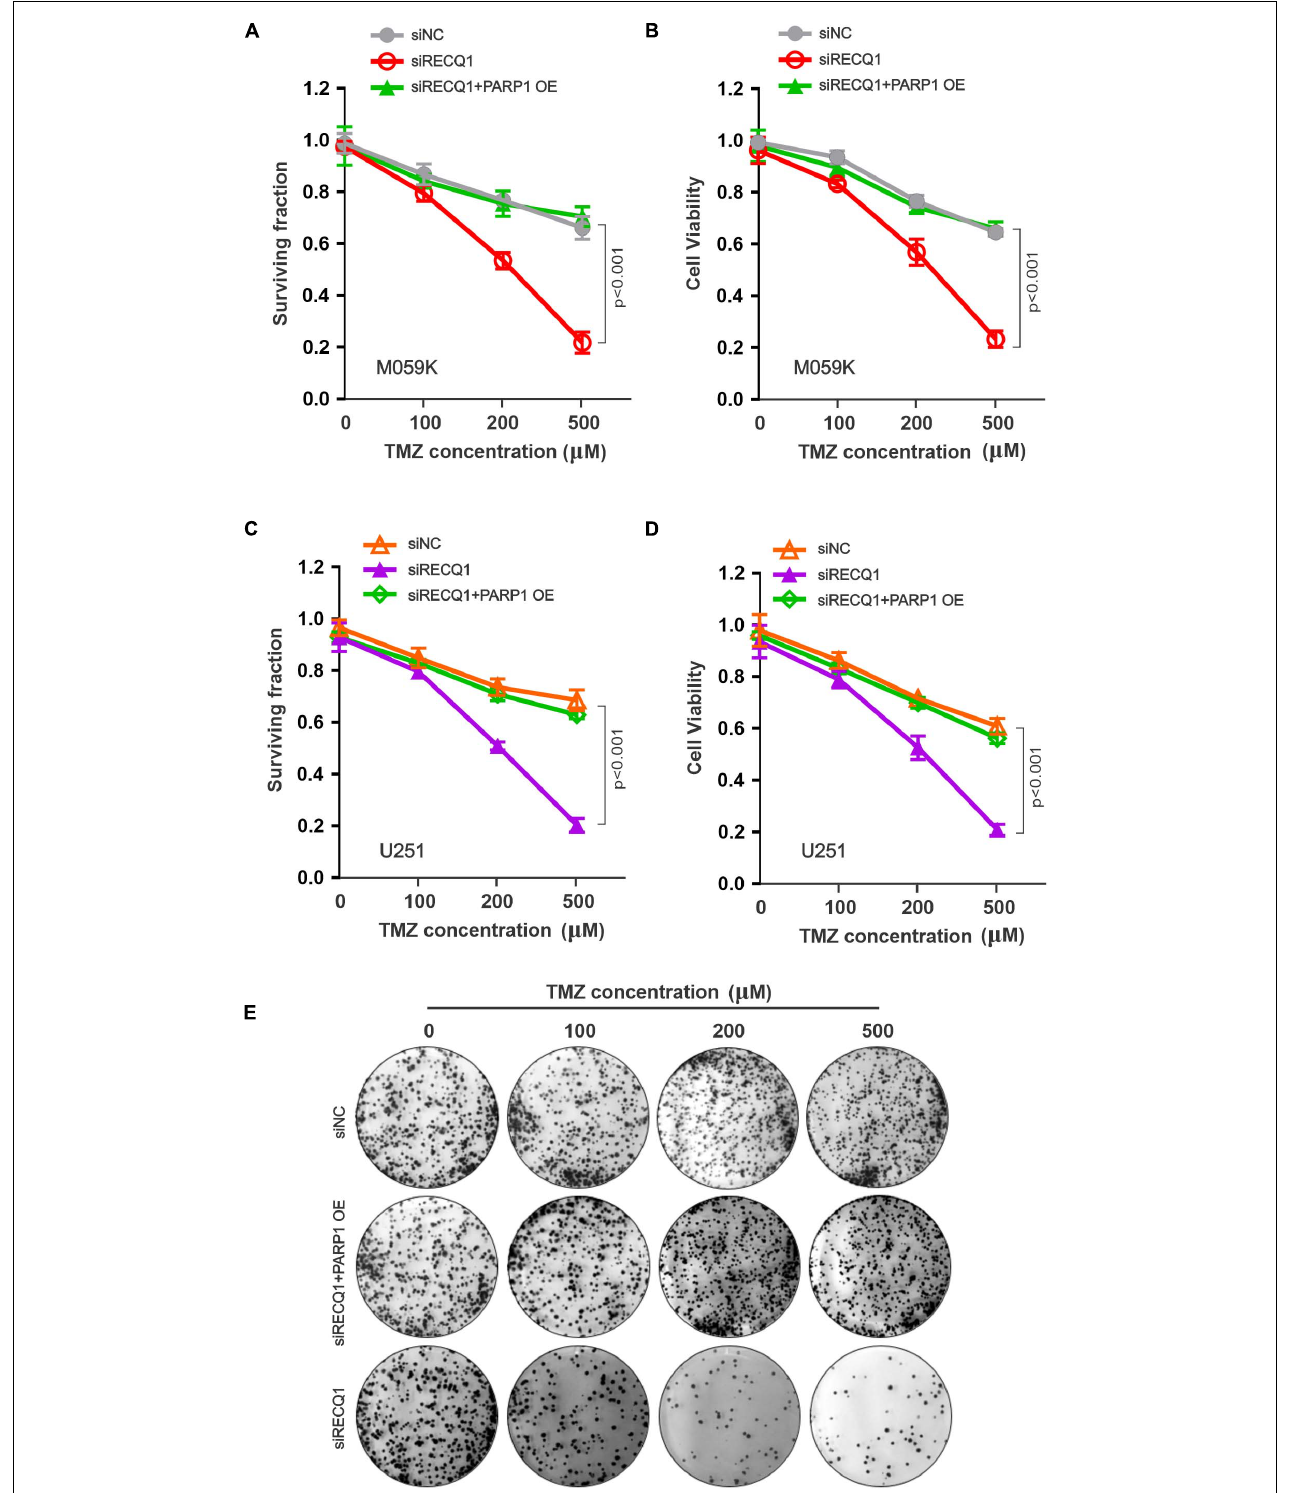
FIGURE 6 | RECQ1 deficient glioblastoma cells are hypersensitive to TMZ treatment. (A) Cellular surviving fractions and (B) cell viability was measured at different concentration of TMZ in M059K cells transfected with siNC, siRECQ1 or combined with PARP1 OE. Surviving fraction and viability values are indicated as mean ± SD from three independent experiments. (C,D) TMZ sensitivity analysis carried out in additional U251 cells. (E) Representative clone images were shown. A two-sided unpaired t -test was used to calculate P -values. Significant: p < 0.05; NS, not significant: P > 0.05.